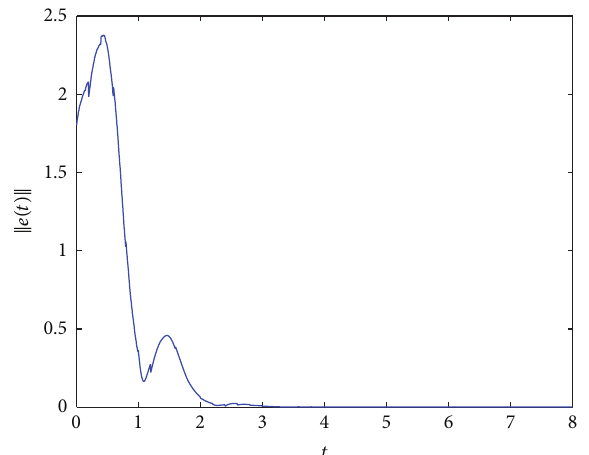
Figure 5: Evolution process of total synchronization error ‖𝑒(𝑡)‖ of two delayed Hopfield neural networks.